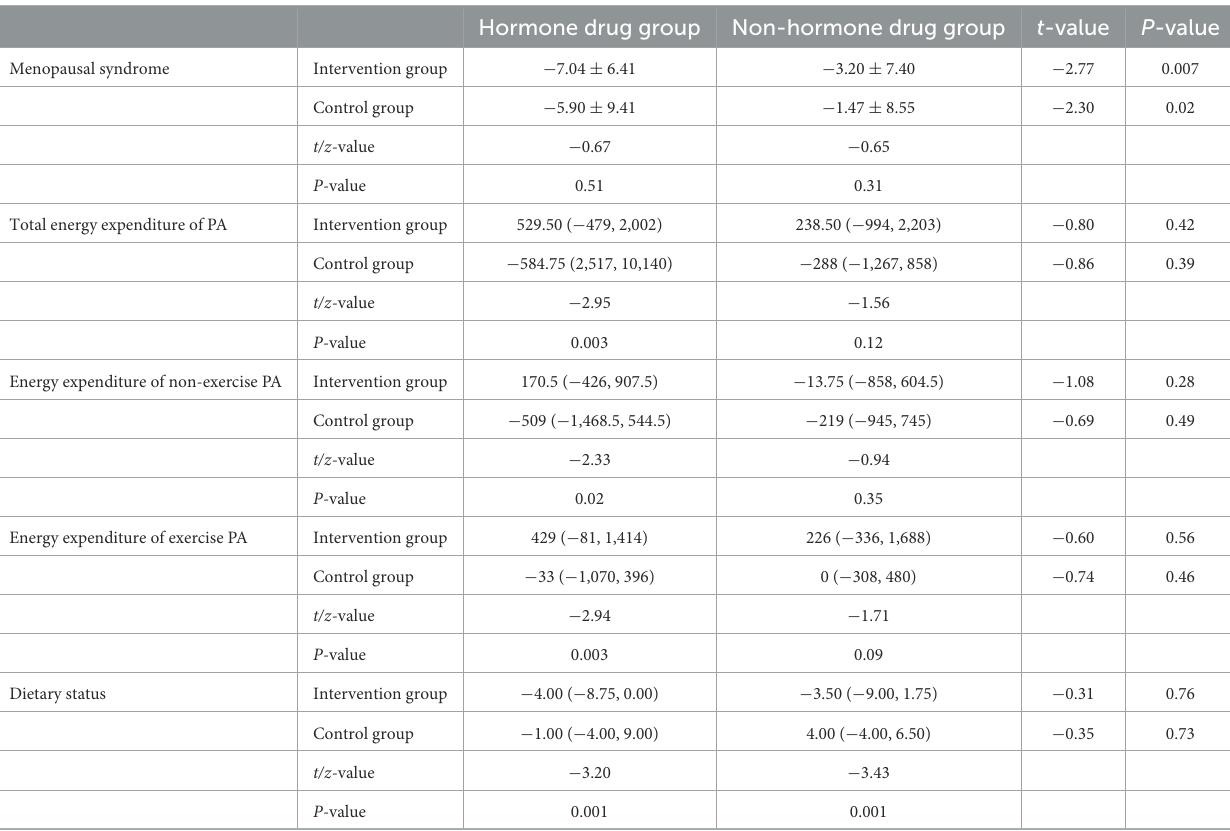
TABLE 4 Changes of KMI, IPAQ and dietary status within and between groups according different drug use status. Hormone drug